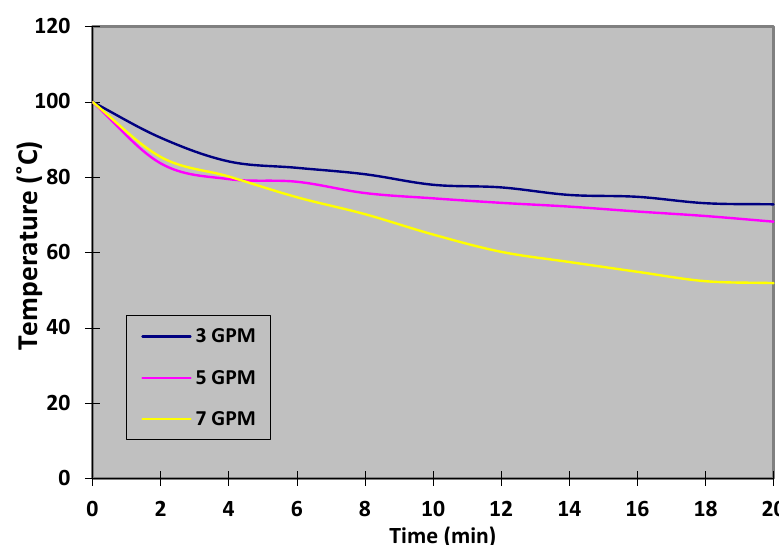
Figure 8. Surface temperature for 50% of distilled water mixed with 50% of ethylene glycol. Figure 9 shows the transient response of the heater block and liquid cold plate with the same procedure of the previous cases. The only difference between the previous cases is the percentage of the distilled water and ethylene glycol. In this case, 25% of distilled water and 75% of ethylene glycol were mixed and used with different flow rates at 0.3, 0.5, and 0.7 GPM. The temperature decreased to 83.8 ◦ C within 4 min at 0.3 GPM, then dropped to 76.8 ◦ C within 14 min, and decreased gradually to 75.1 ◦ C within 20 min. After switching off the system for about 40 min, the temperature of the heater block cooled